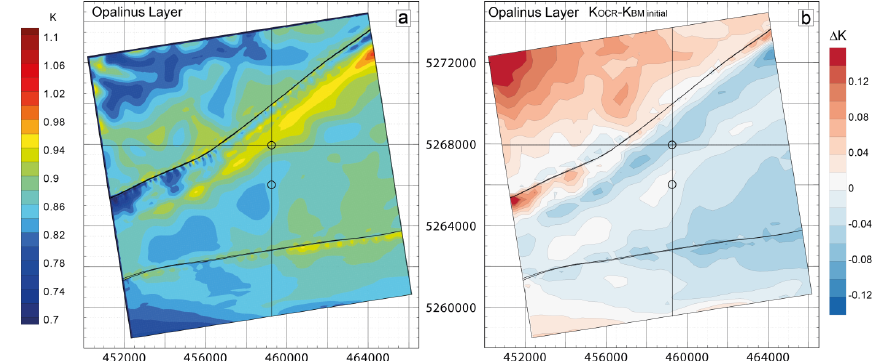
Figure 6. Initial stress state of the model at mid-depth of the Opalinus Clay formation (i.e. stress state without tectonic loading). (a) K = S h /S V of the initial stress. (b) Difference between the theoretical K ratio from Eq. (4) and the initial stress state in the model as shown in (a) . Small circles indicate the location of the two depth profiles displayed in Fig. 7c and f, the northern of which is the location of the Weiach